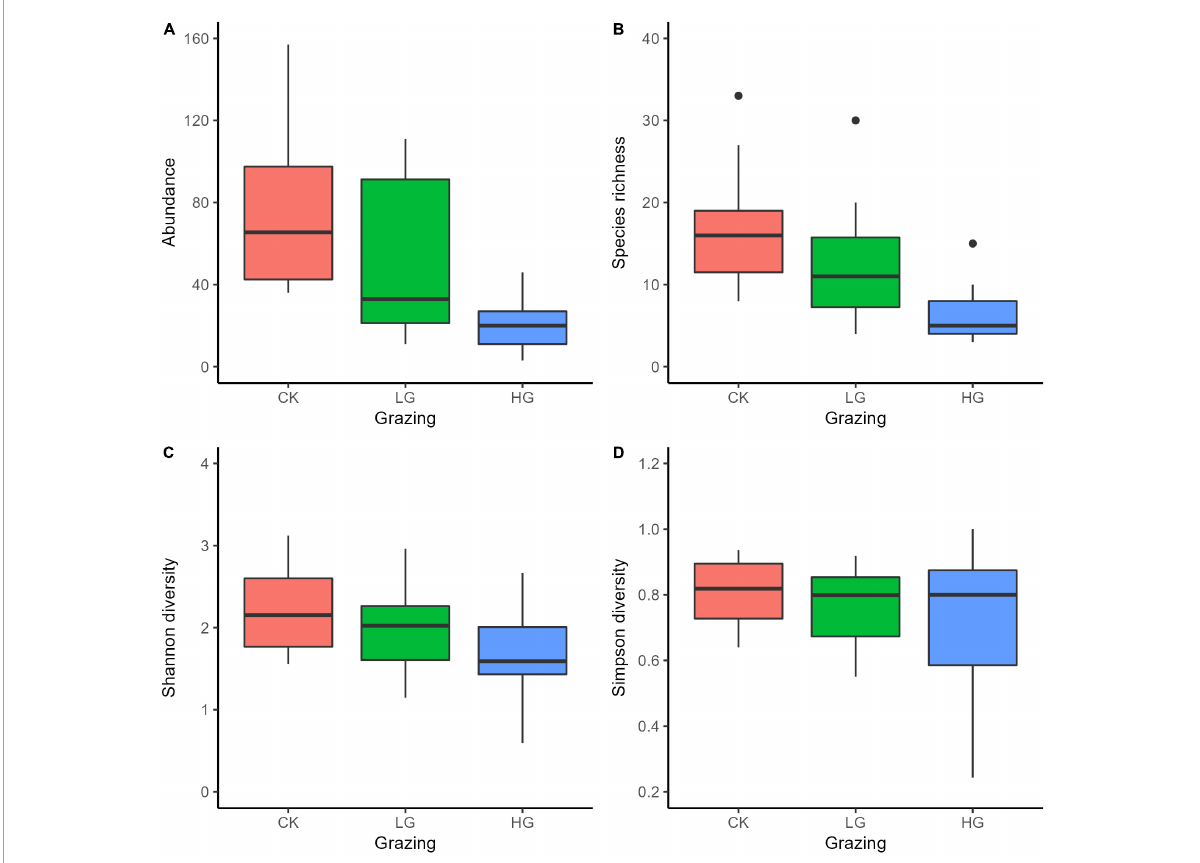
FIGURE3 Boxplots of insect species abundance (A) , richness (B) , Shannon diversity (C) , and Simpson diversity (D) in three grazing intensities in a desert steppe: Ungrazed plot (CK), light grazed (LG), and heavily grazed (HG).